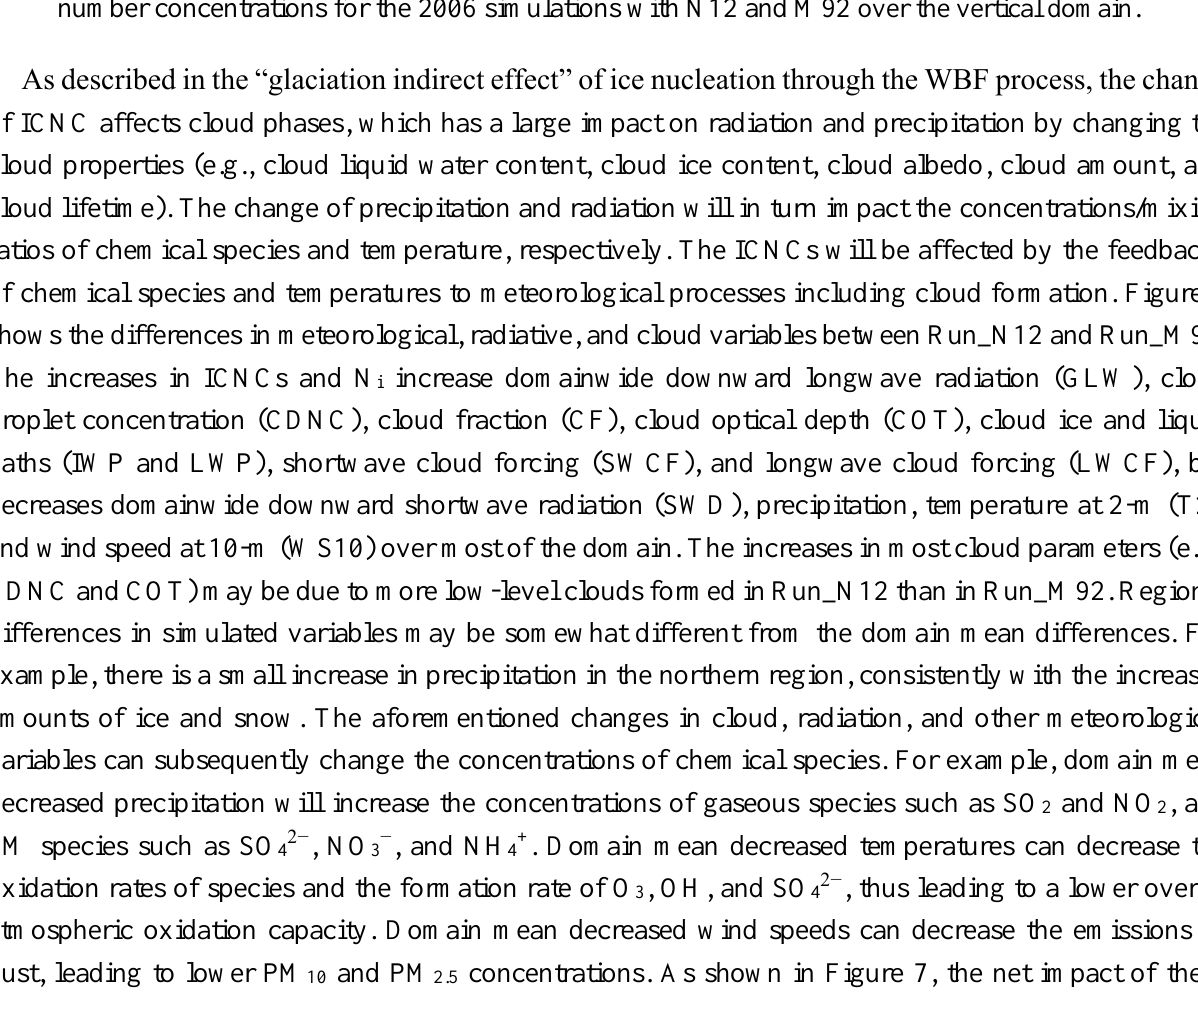
Figure 5. Absolute and percentage differences of zonal mean distributions of Q and aerosol number concentrations for the 2006 simulations with N12 and M92 over the vertical domain